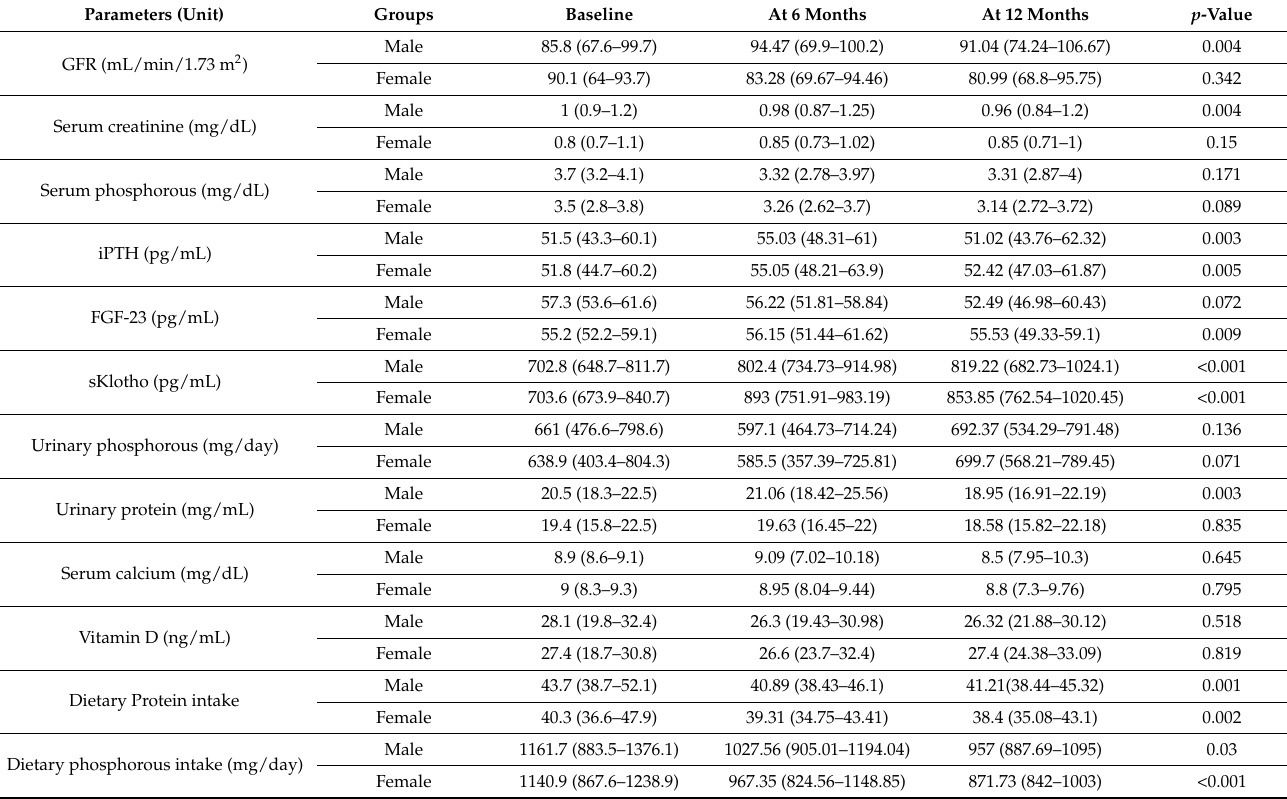
Table 9. Comparison of biochemical parameters before and after dietary counselling and dietary intervention on the basis of